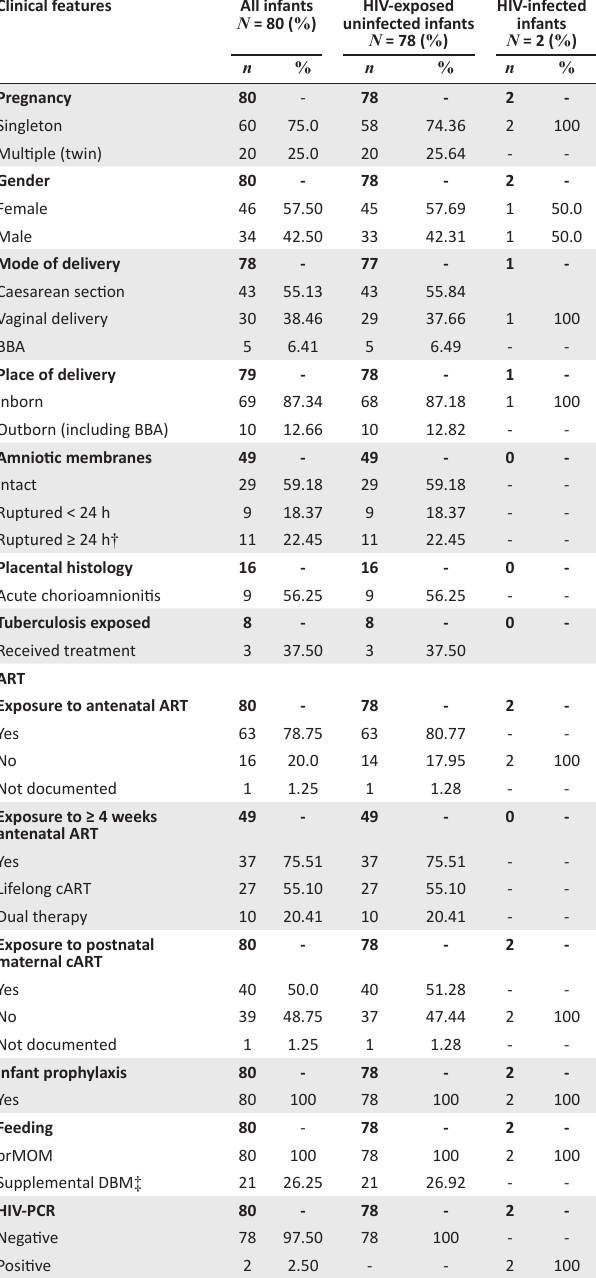
TABLE 4: Infant characteristics. Clinical